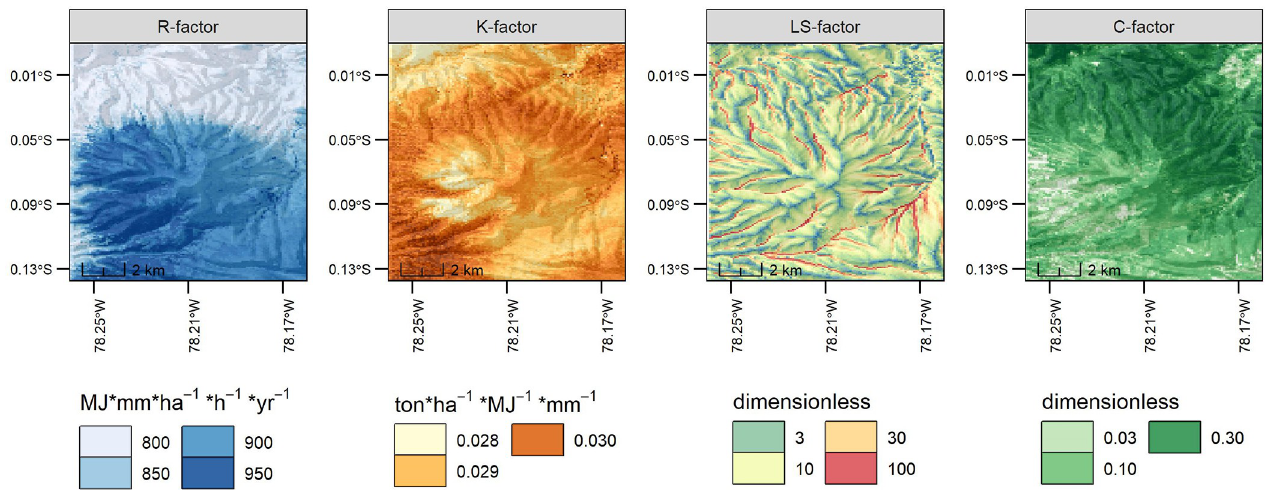
Fig 2. Spatial representation of the factors required in the RUSLE